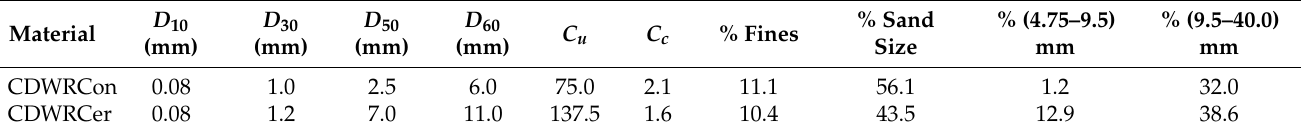
Table 2. Aggregate type and particle size distribution characteristics of the CDWRCon and CDWRCer.